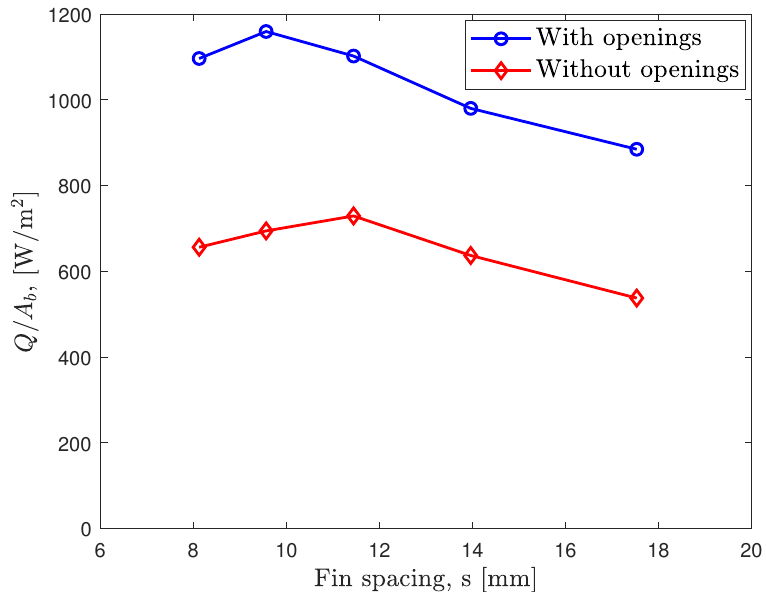
Figure 5. Comparison of heat transfer characteristics of straight rectangular fins with and without openings in the base ( L = 512 mm, W = 512 mm, H = 40 mm, t = 2 mm, and ∆ T = 40 ◦